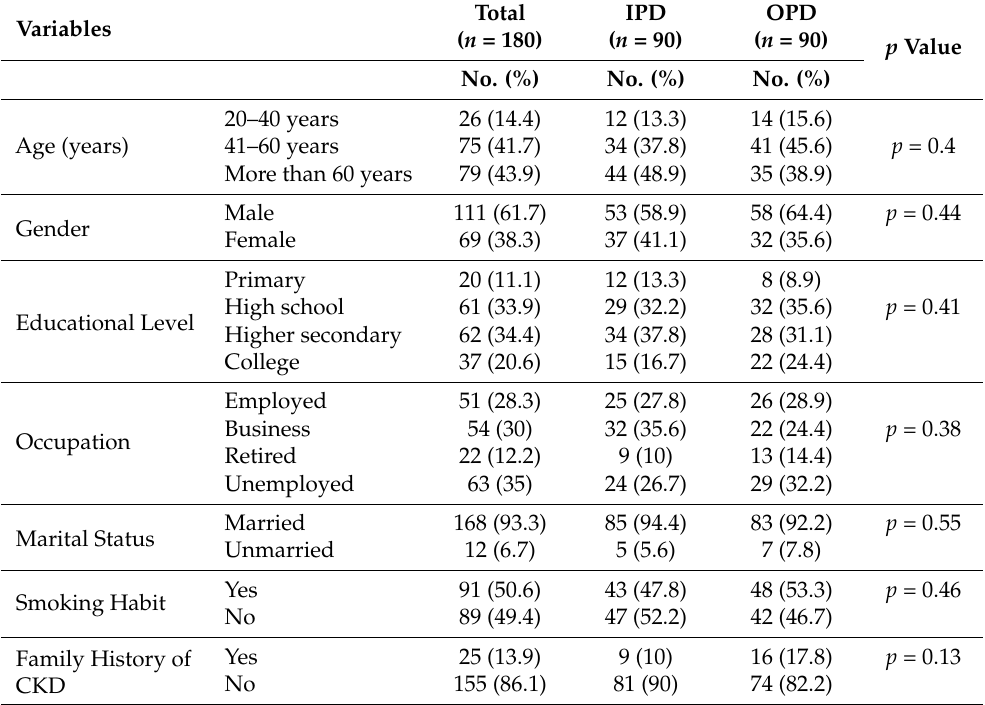
Table 1. Demographic information of the patients.